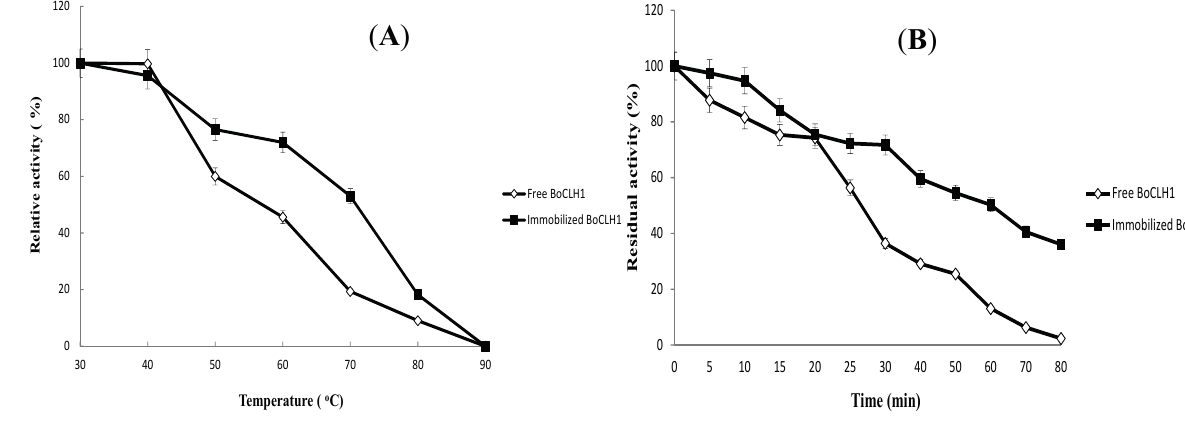
Figure 4. Thermostability of free and immobilized BoCLH1. ( A ) Free enzyme ( ◊ ) and the immobilized enzyme ( ■ ) were incubated at different temperatures (30–90 °C) for 30 min prior to activity analysis. ( B ) The thermal inactivation of the free enzyme ( ◊ ) and the immobilized enzyme ( ■ ) were incubated at 60 °C for various time intervals (0–80 min). A Cu(II)-loaded metal chelator was used for